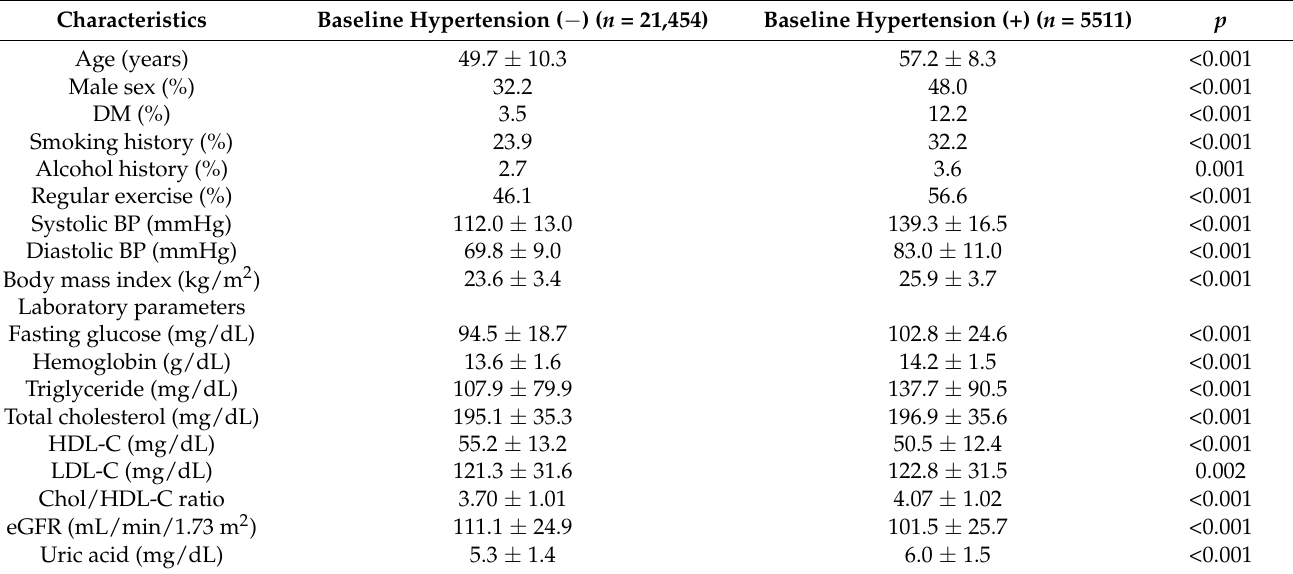
Table 1. Comparisons of clinical characteristics between baseline hypertension groups ( n =